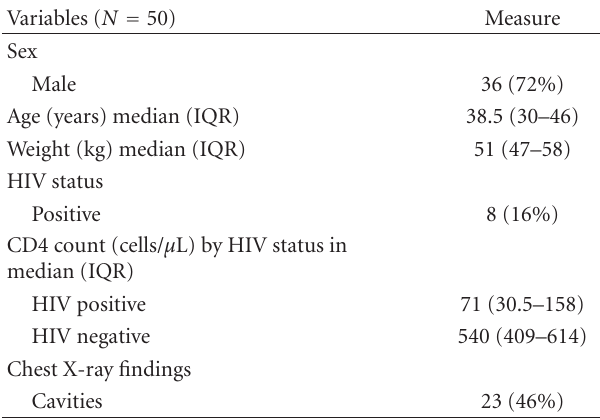
Table 1: Demographic and clinical